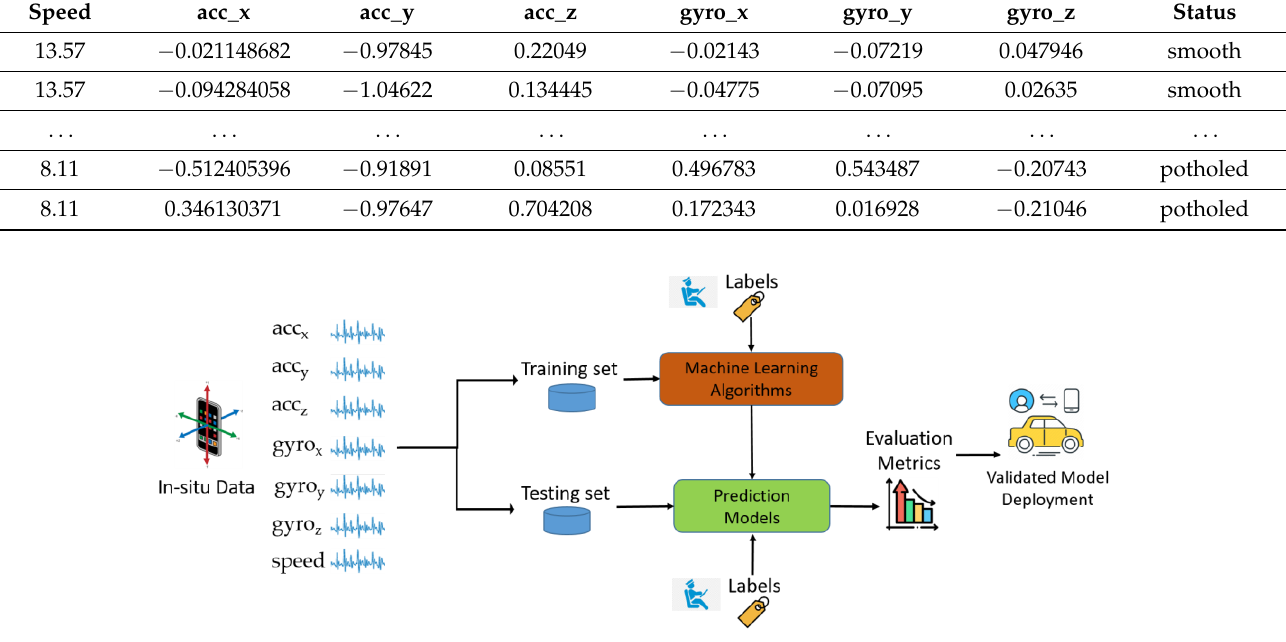
Figure 6. The steps from in situ data collection to model deployment.